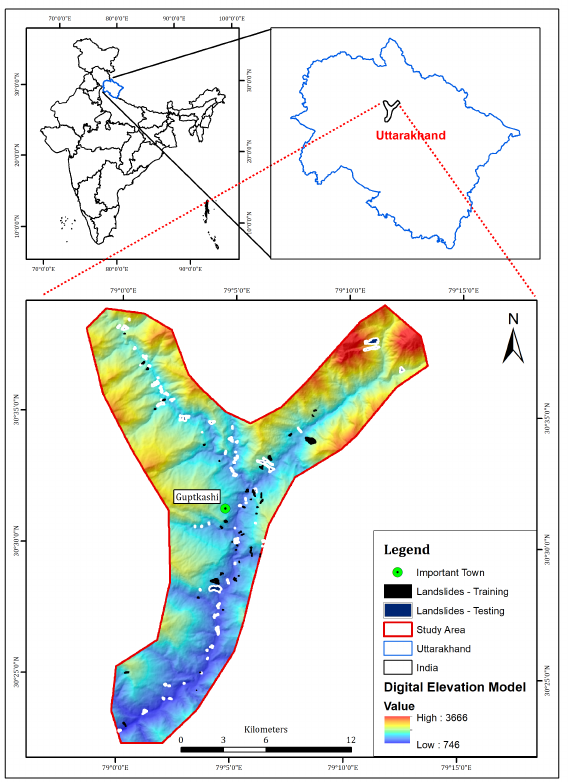
Figure 1. Map of study area (Source: Boundary of India and Uttarakhand provided by Survey of India, DEM provided by